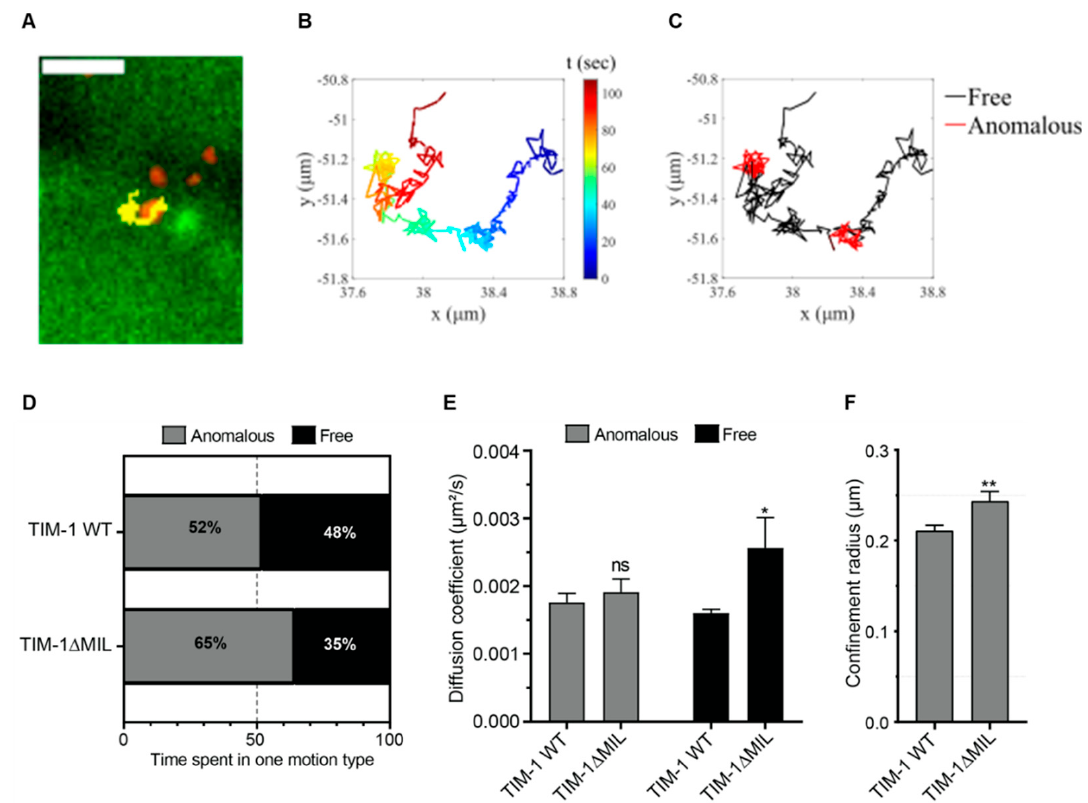
Figure 3. Single particle tracking of CHIKV confirms PtdSer domain requirement. ( A ) Overlay of the fluorescence image of CalceinAM stained TIM-1 WT cells (green) and labeled Asian mc-CHIKV particles (red) with the virus diffusion trajectory (yellow) at the cell surface. The bar represents 2 µ m. ( B ) The CHIKV trajectory shown in ( A ) as a time-lapse with the time in seconds presented as a color bar ( C ) Segmentation of the trajectory shown in ( B ) and classification of the segments using moment scaling spectrum (red: anomalous confined motion—black: Brownian free motion). ( D ) The fraction of time spent by the mobile particles either in confined anomalous or Brownian free motion. The total number of viruses analyzed here is N virus = 1523, 472 for TIM-1 WT and TIM-1 ∆ MIL respectively. ( E ) The mean of the diffusion coefficient for anomalous and free motion of each segment is calculated using MSS as described in methods. ( F ) The confinement radius of the anomalous motion is presented for each cell type. The error bars represent standard errors of the mean (SEM) with N segments = 1296, 414 for TIM-1 WT and TIM-1 ∆ MIL respectively. Statistical significance was calculated using a Welch t -test with ns > 0.05, * p < 0.05 and ** p < 0.01. For D, the percentage of fraction was obtained by counting, so no statistical analysis is